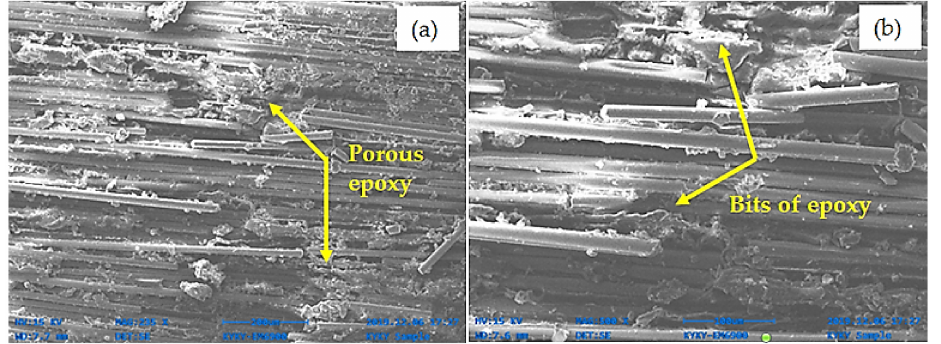
Figure 7. SEM images of 24-day water-aged specimens with magnification: ( a ) 235 × and ( b ) 500 × .